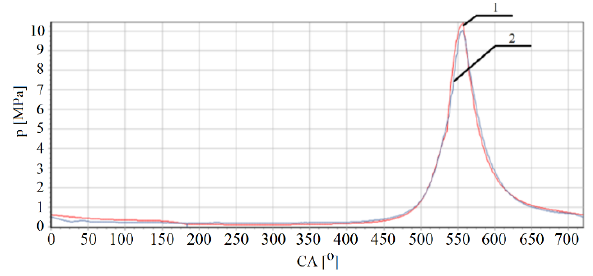
Fig. 2. The course of the indicated pressure obtained as a result of model tests – 1, and empirical tests – 2 as a function of the angle of rotation of the crankshaft